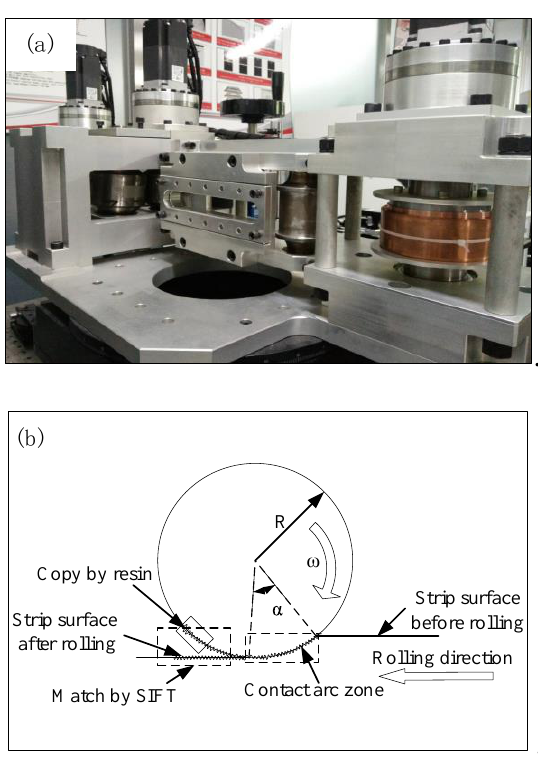
Figure 1. Experimental equipment. ( a ) Rolling mill. ( b ) Rolling process.